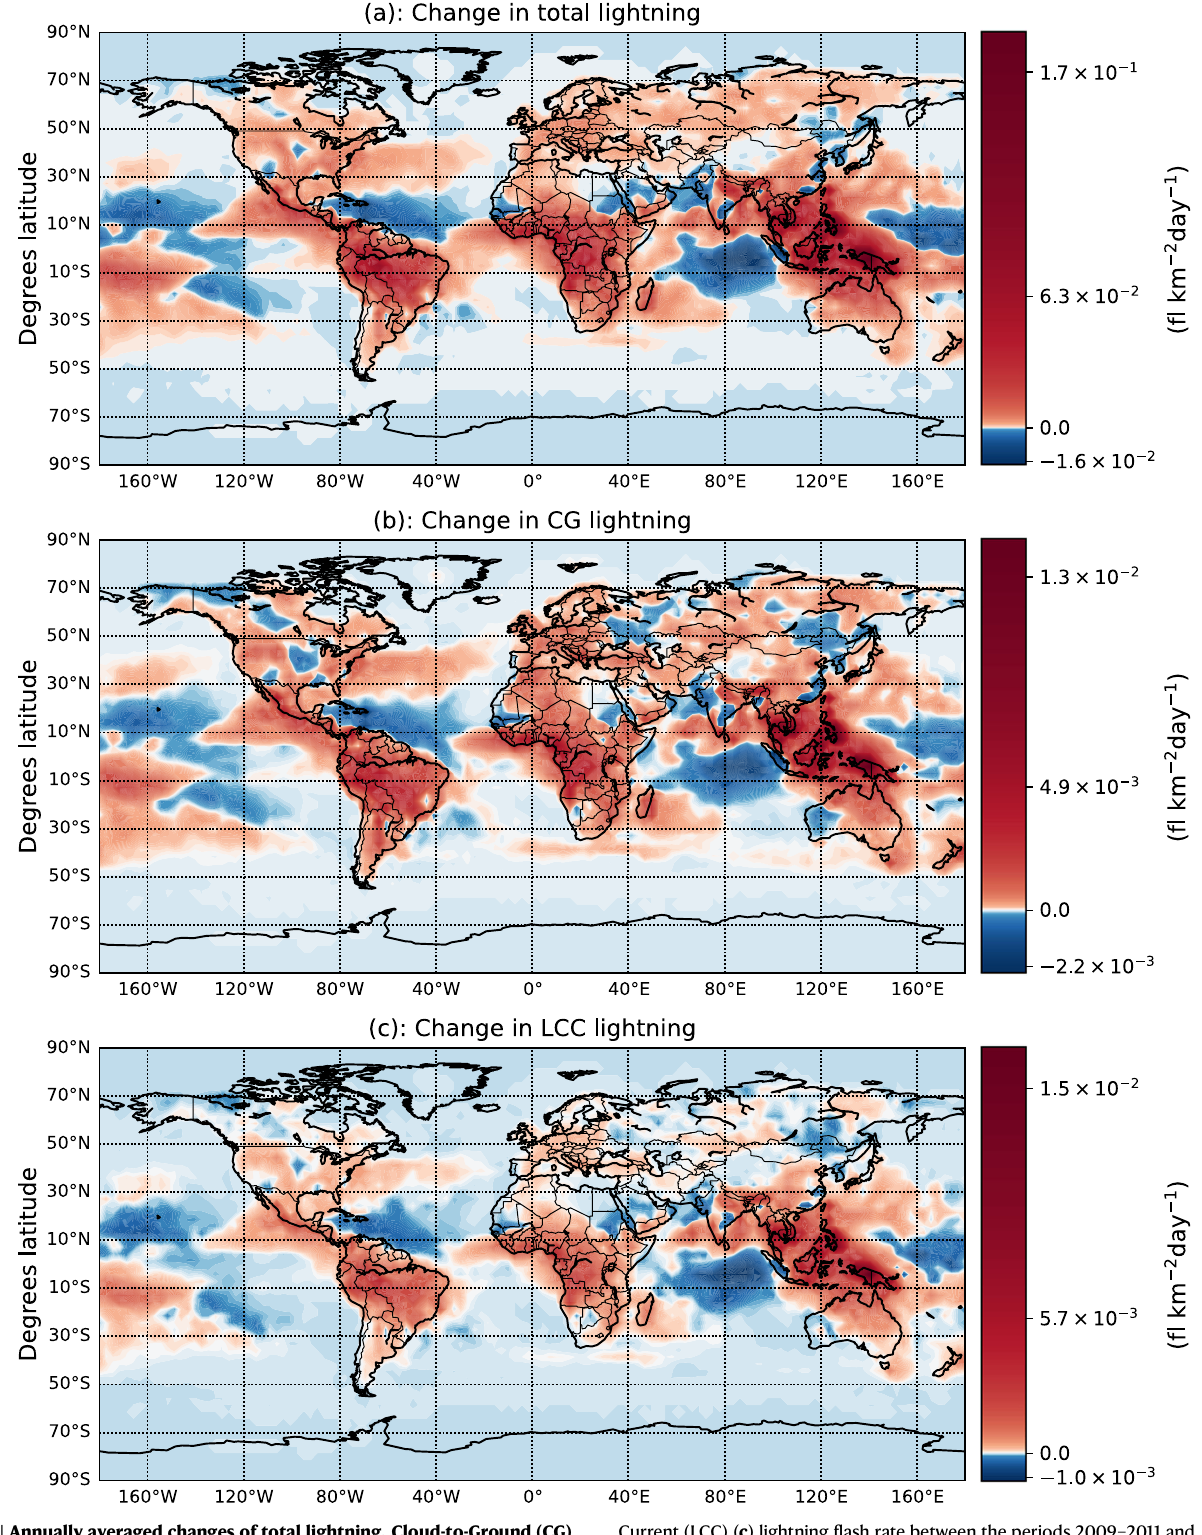
Current (LCC) ( c ) lightning fl ash rate between the periods 2009 – 2011 and 2091 – 2095. Changes are calculated as the difference between the Representative Concentration Pathway RCP6.0 and present-day